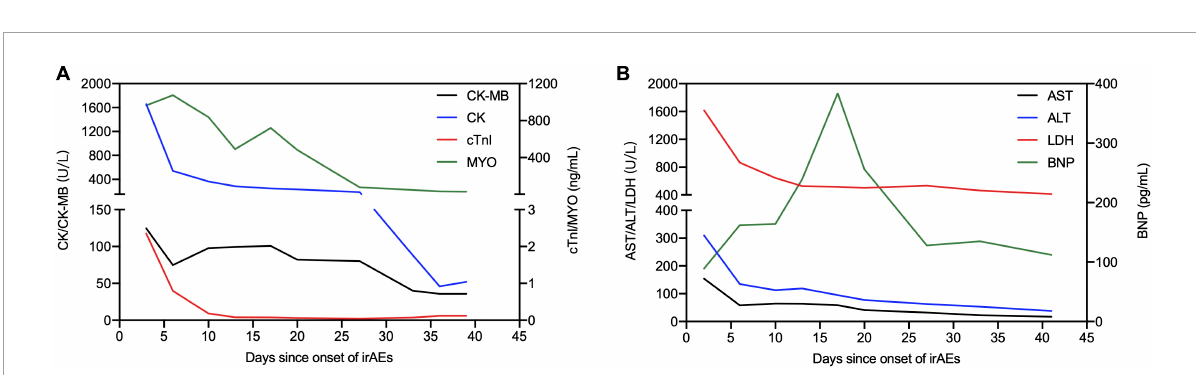
FIGURE2 Illustration of main laboratory markers and steroid treatment following the onset of irAEs. (A) Dynamics of cardiac markers [creatine kinase (CK), creatine kinase isoenzyme (CK-MB), cardiac troponin I (cTnI), and myoglobin (MYO)]. (B) Dynamics of other biochemical markers [alanine aminotransferase (ALT), aspartate aminotransferase (AST), lactate dehydrogenase (LDH), and brain natriuretic peptide